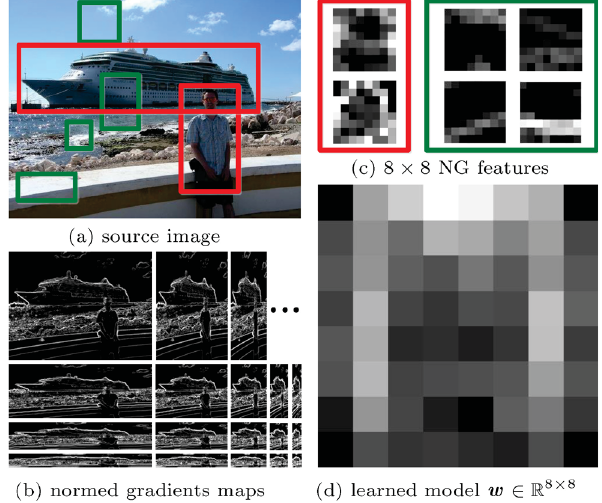
Fig. 1 Although object (red) and non-object (green) windows vary greatly in image space (a), at proper scales and aspect ratios which correspond to a small fixed size (b), their corresponding normed gradients (NG features) (c), share strong correlation. We learn a single 64D linear model (d) for selecting object proposals based on their NG